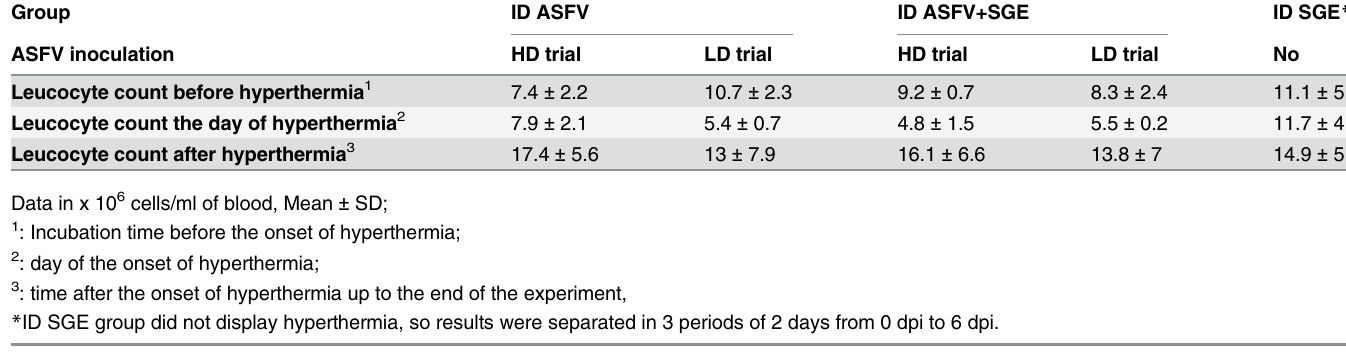
Table 2. Blood leucocyte mean count kinetics (x 10 6 cells/ml of blood) presented in relation to hyperthermia. Group ID